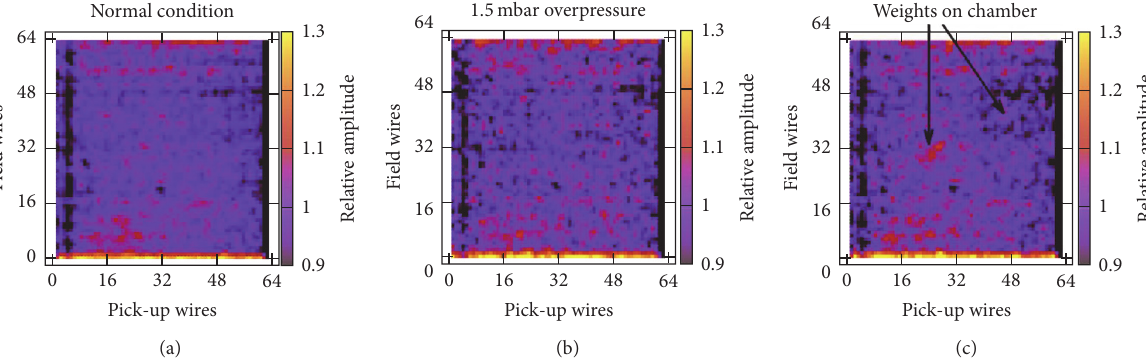
Figure 10: Gain map (mean amplitude) of the top detector layer (1) in the horizontal configuration, under various test conditions. (a) is the reference and (b) shows the map for 1.5mbar overpressure, (c) with two test weights placed directly on the detector (indicated by the arrows).